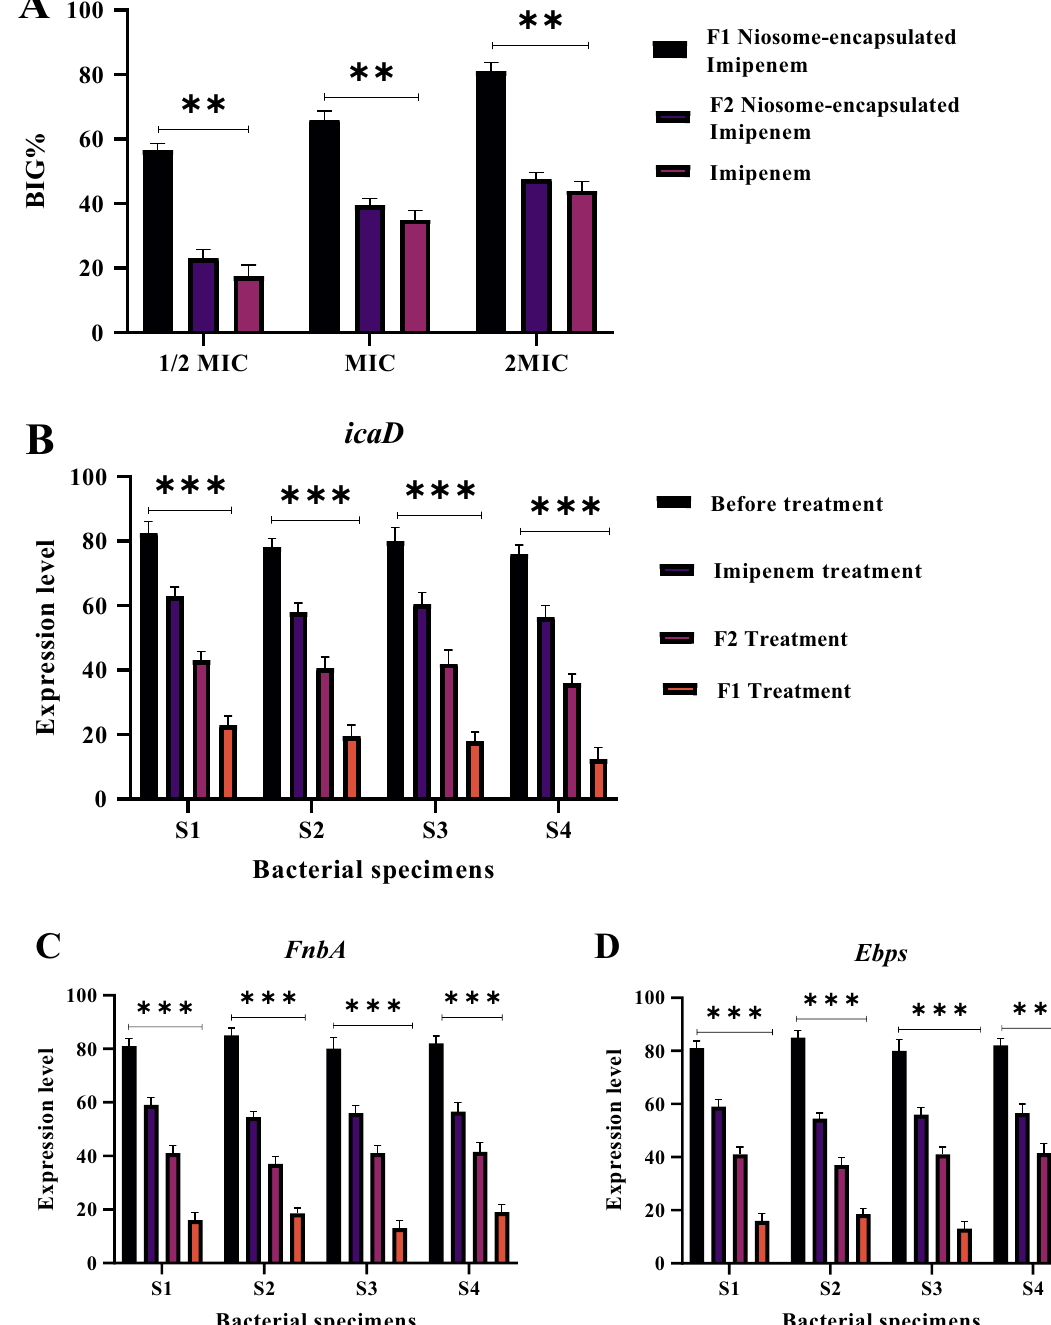
Figure 3. ( A ) Biofilm growth inhibition percentage of various formulations of Niosome-encapsulated Imipenem. ( B – D ) Effect of various drug formulations on biofilm gene expressions. The results show that F1 formulation has the greatest effect on reducing the expression of biofilm genes (ns, p > 0.05, *** P < 0.001 , ** p < 0.01, * p < 0.05. n =